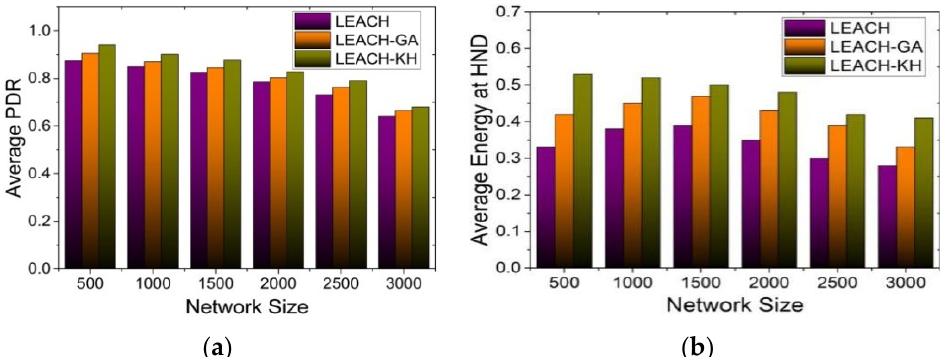
Figure 12. Comparison graph of LEACH, LEACH-GA, and LEACH-KH. ( a ) Packet delivery ratio; ( b ) Residual Energy at Network